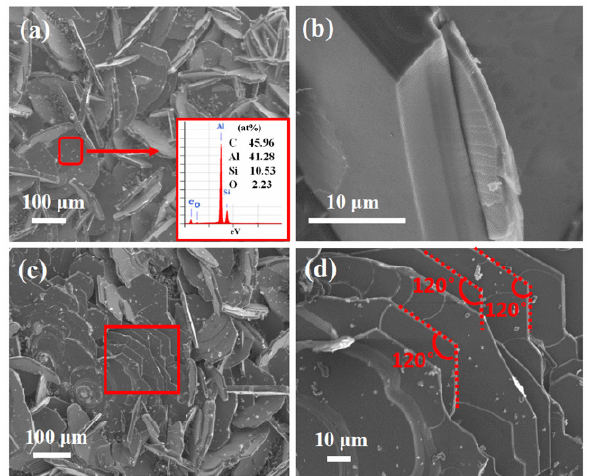
Fig. 2 SEM images of the synthesized Al 4 SiC 4 powders by carbothermic reduction. (a) General morphology of synthesized Al 4 SiC 4 powders, the inset: EDS analysis of the grain in the rectangle in (a); (b) thickness of the grains; (c) and (d) detailed stacking layer of Al 4 SiC 4 grains with hexagonal plate-like feature; (d) enlarged SEM image of the red rectangle in (c).